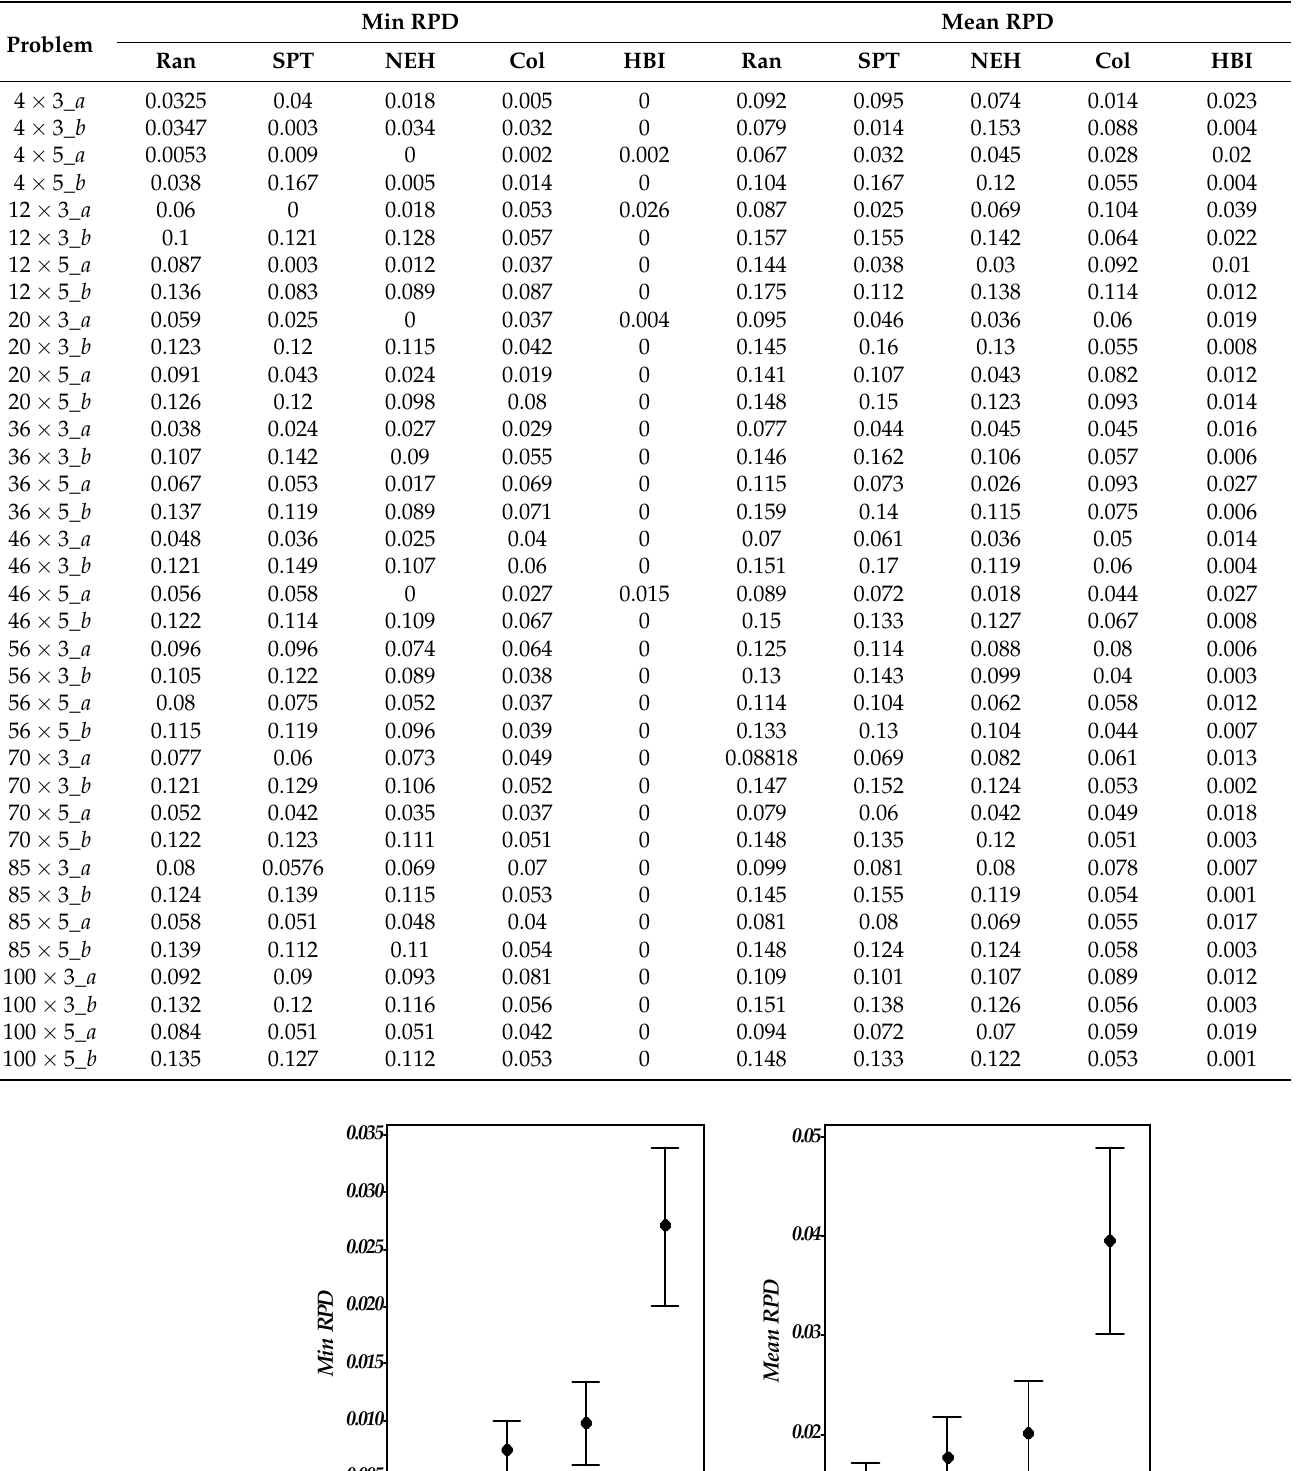
Table 3. Comparisons of the initialization rules.